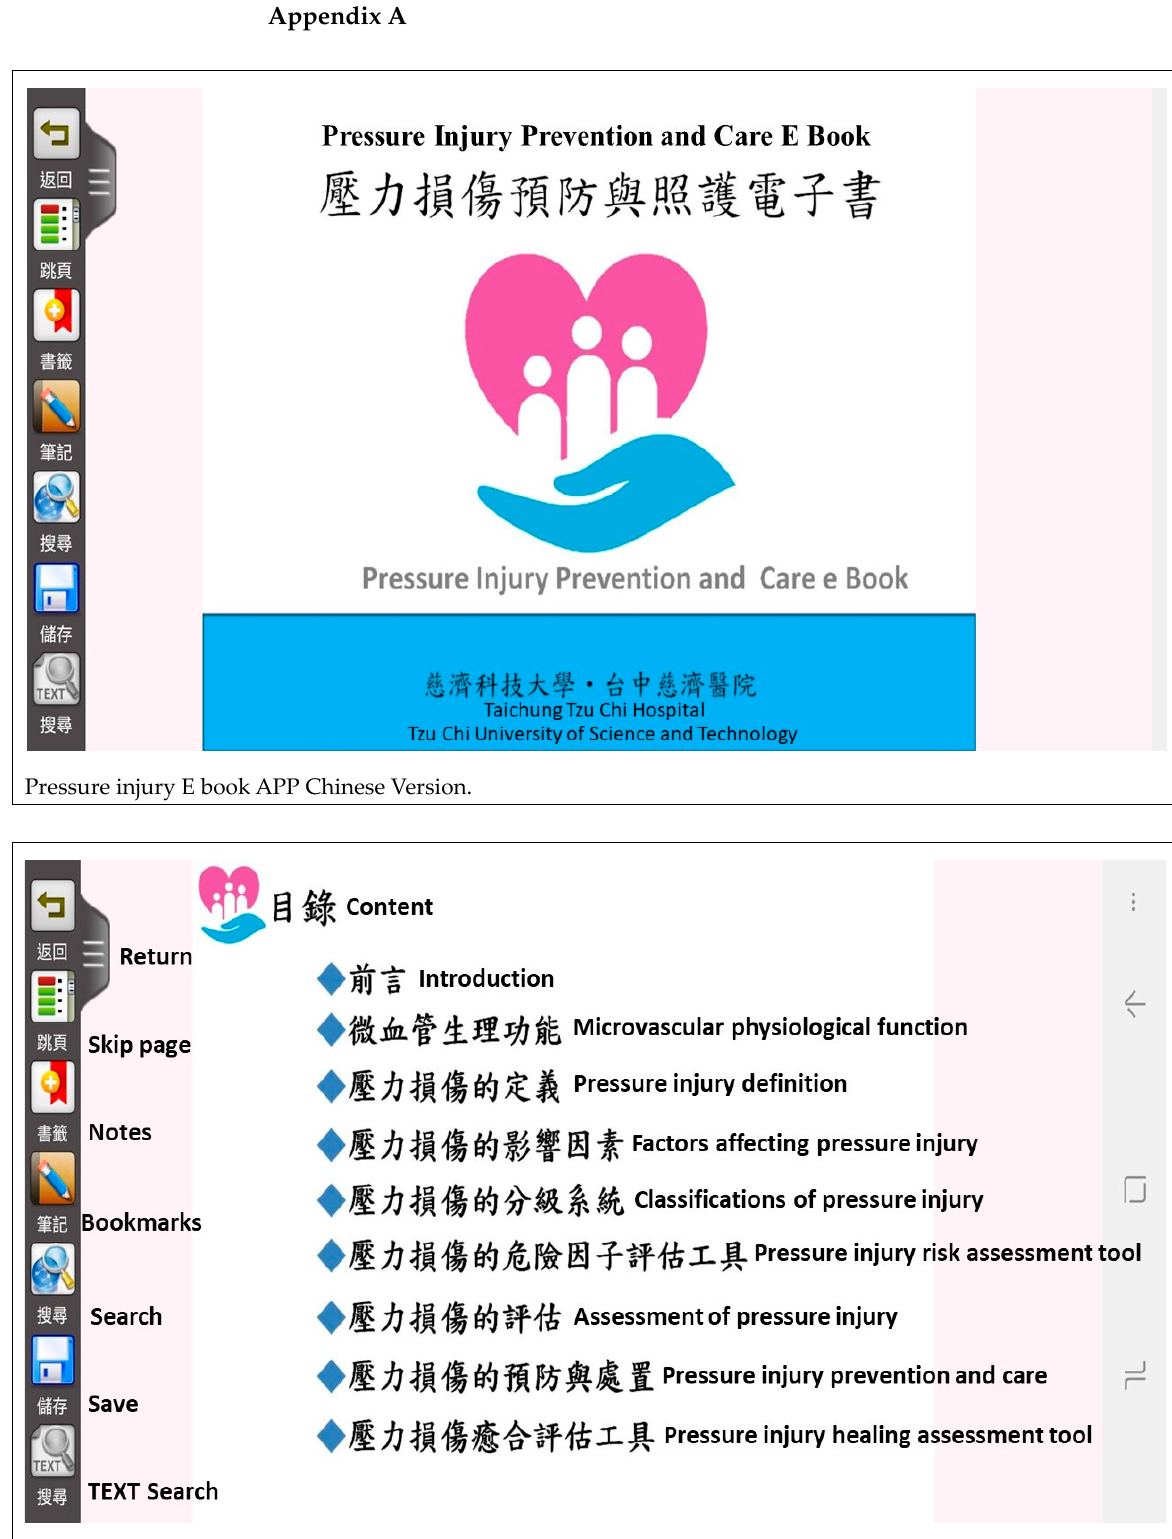
Figure A1. Pressure injury E-book